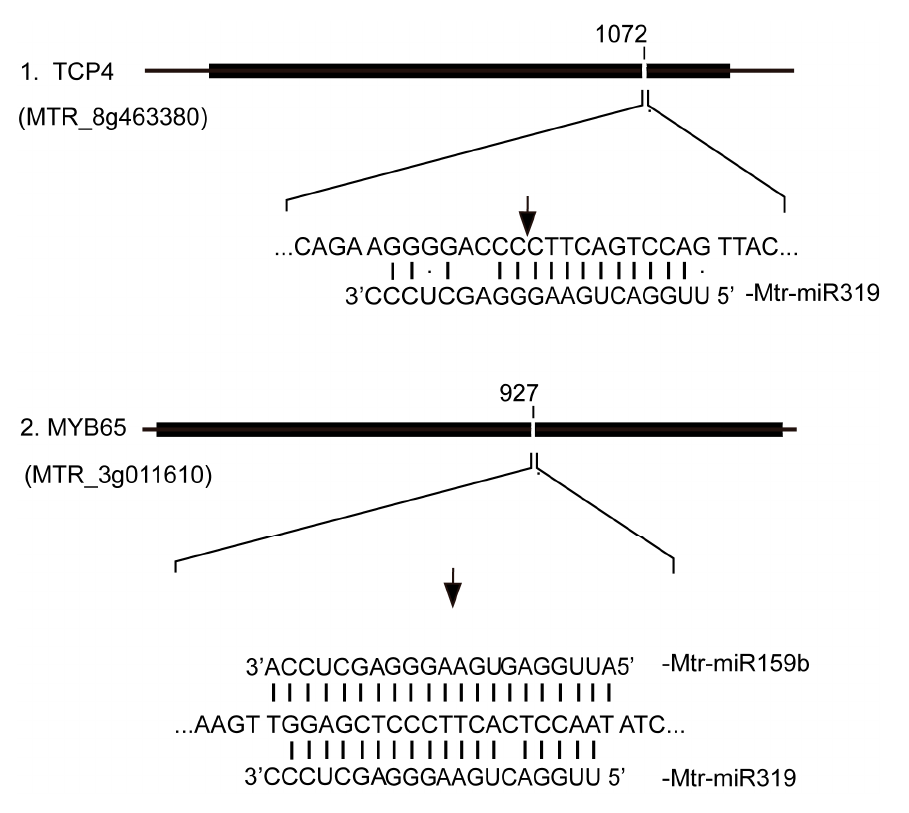
Figure 9. Diagrammatic representation of the cleavage sites of two miRNA targets. The CDS (coding sequence) of target gene is represented by black boxes and the cracks are the complementary site of miRNA. Black arrows indicate the exact cleavage site of mRNA.